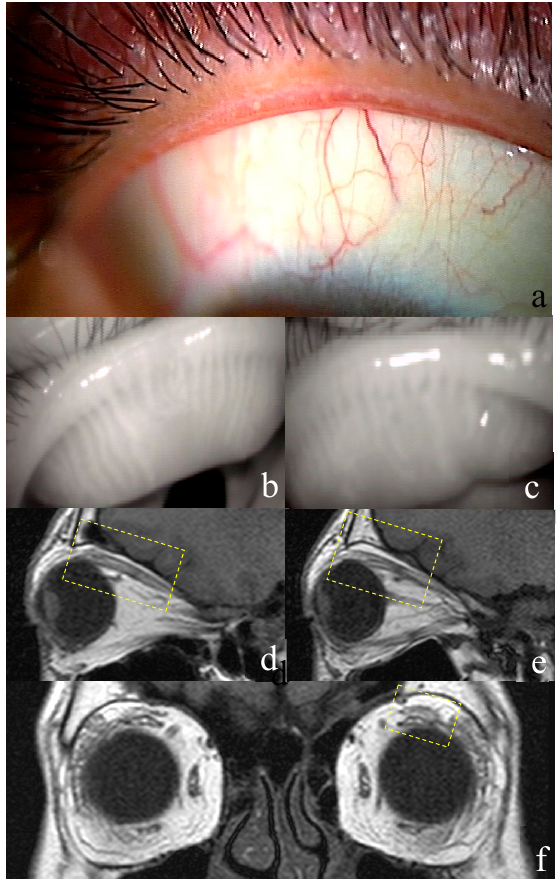
Figure 1. Representative case of a 53-year-old woman with Graves’ ophthalmopathy. The patient presented with vascular engorgement, lid-margin inflammation, and plugging of the lid margin ( a ). The meibomian glands at the central region of the eyelids exhibit abnormal findings, particularly in the upper eyelid ( b , c ). Magnetic resonance imaging findings show enlargement of the levator muscle and lacrimal gland ( d – f ).